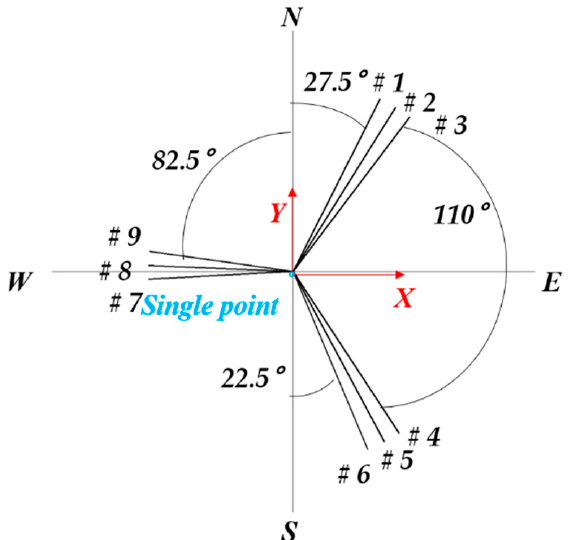
Figure 3. Ship surface model.